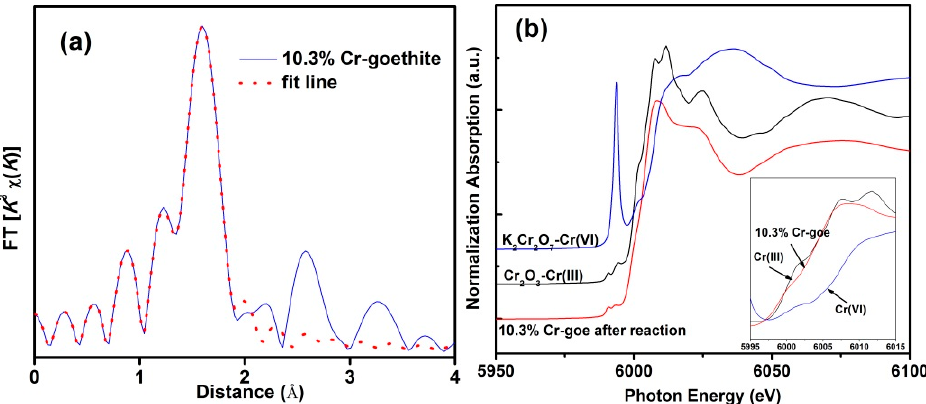
Figure 2. Scanning electron microscopy (SEM) images of pure goethite and 0.09 ratio of [Cr]:([Cr] + [Fe]) Cr-goethite (9.03% Cr-goethite) before and after reaction with Fe(II) aq . ( a ) Pure goethite, ( b ) pure goethite after reaction for 30 days, ( c ) 9.03% Cr-goethite, and ( d ) 9.03% Cr-goethite after reaction for 30 days. Conditions: [Fe(II) aq ] = 1 mM, [goethite] = 2 g/L, pH 7.5 controlled with 25 mM 4-(2-hydroxyethyl)-1-piperazineeth anesulfonic acids (HEPEs)/KBr.